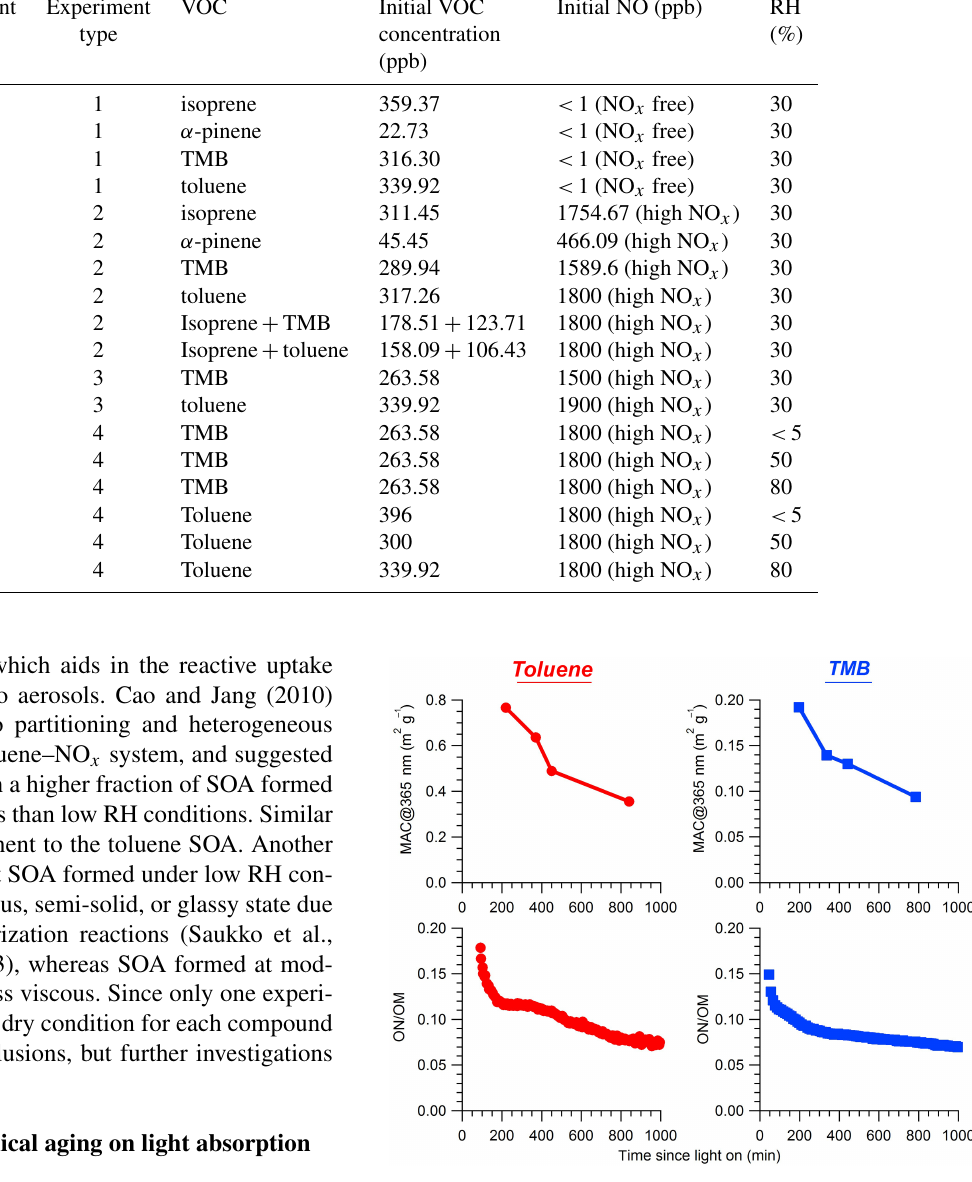
Figure 6. Measurements of the MAC values (at 365nm) of toluene and TMB SOA formed at 30% RH in the presence of NO x as a function of photochemical age (top panels). The bottom panels show the AMS-measured ON-to-OM